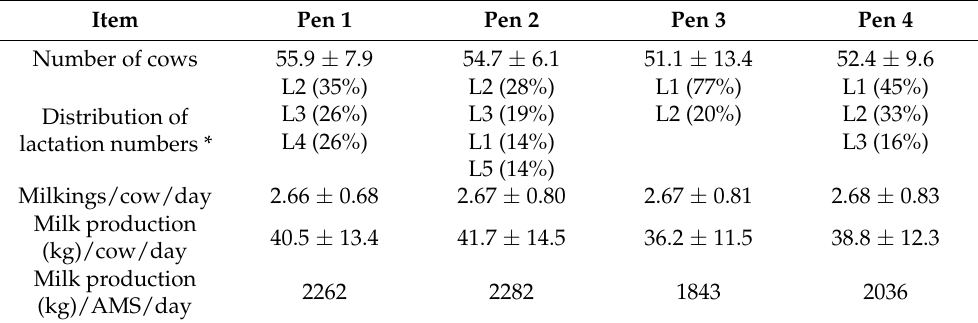
Table 1. Average and standard deviation by pen of farm characteristics for a 12-month period (February 2019–February